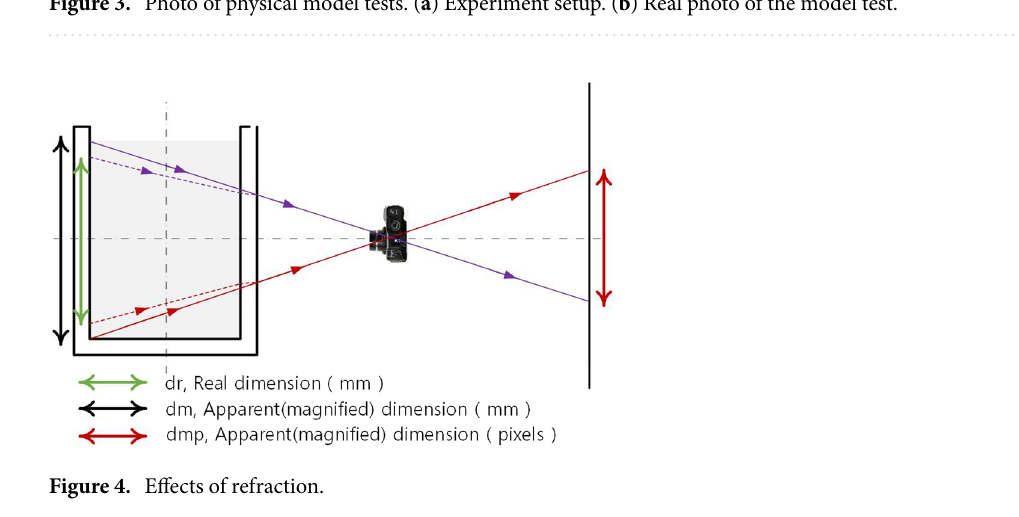
Figure 3. Photo of physical model tests. ( a ) Experiment setup. ( b ) Real photo of the model test.